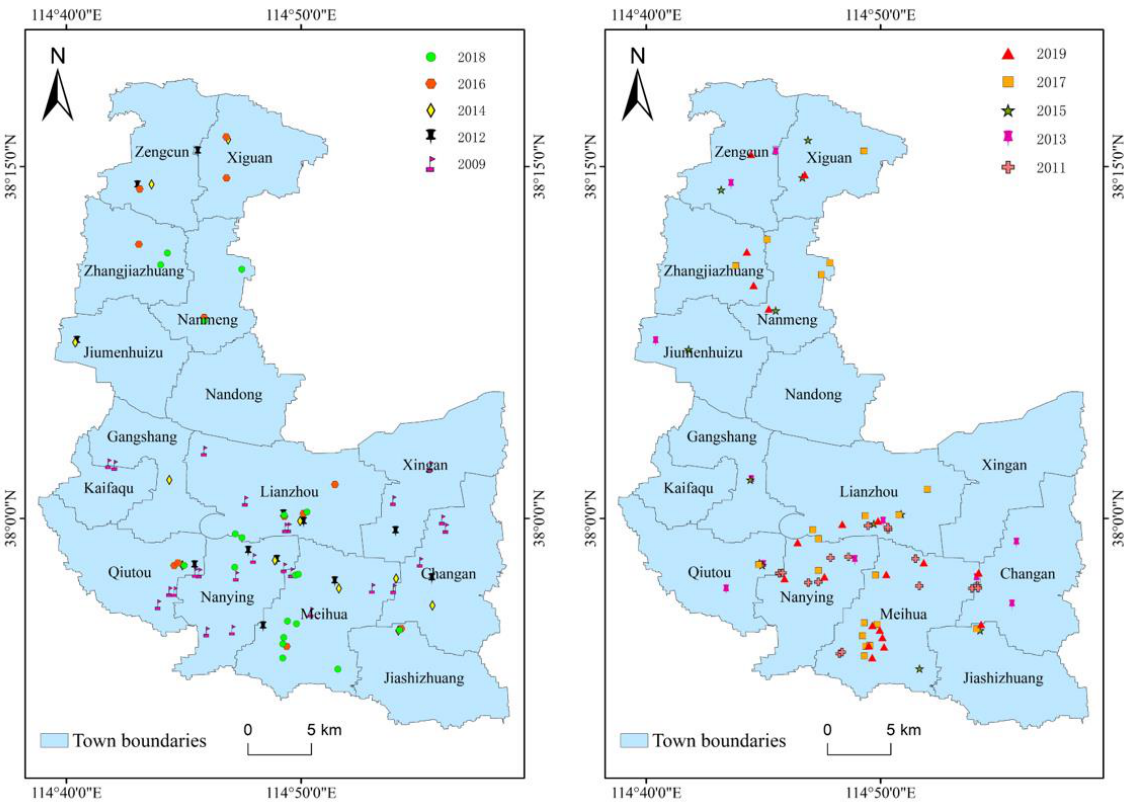
Figure 3. Spatial distribution of field sample sites.